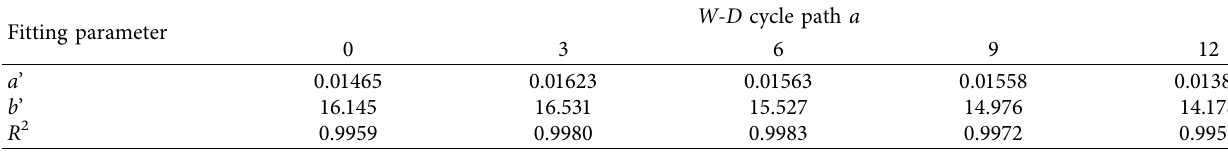
Table 7: Fitting parameters of G